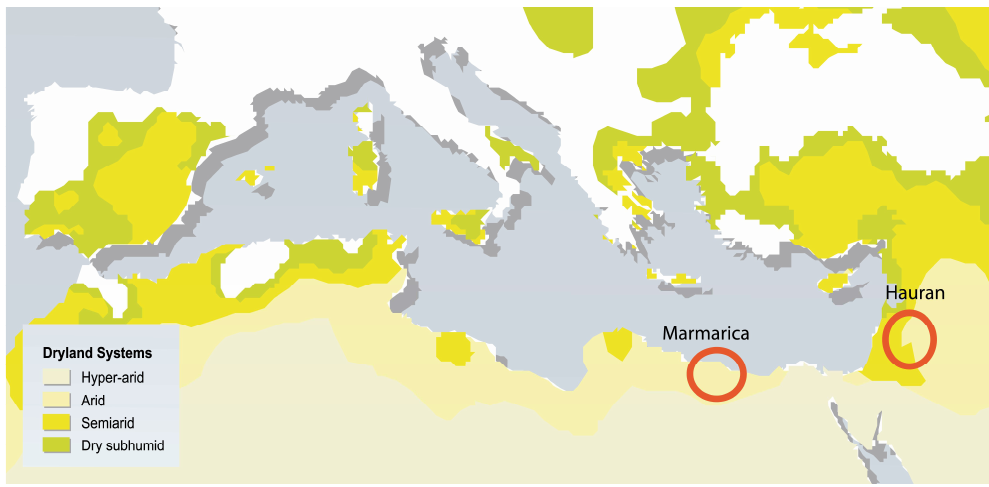
Figure 1. The Mediterranean and the MENA-region (Middle East and Northern Africa) showing the grades of aridity. The red circles mark the areas of the two case studies: the Marmarica in NW-Egypt (left circle), the Hauran in Southern Syria/Northern Jordan (right circle). Both are semi-arid to arid landscapes. Base map: [27] (p. 23).